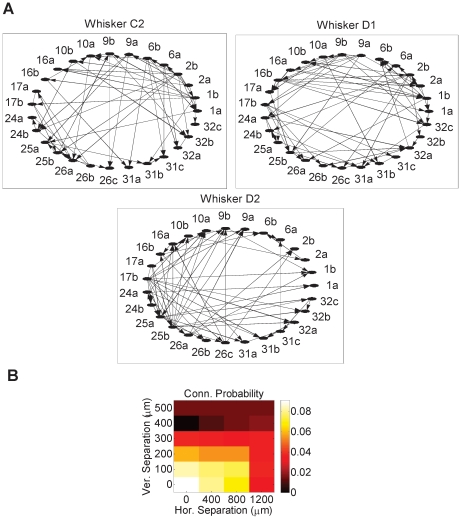
Sample whisker-specific networks.(A) DBN networks inferred from one population (Rat R2) for 3 individually stimulated whiskers: C2, D1 and D2. Undirected links indicate bidirectional connections. Network of each whisker was inferred from a dataset of length 18 sec (180 trials x 100 ms). (B) Connection probability in the DBNs as a function of the horizontal and vertical separations between the electrodes on which neurons were recorded. The number of connections inferred at each distance was normalized by the corresponding total number of possible connections.